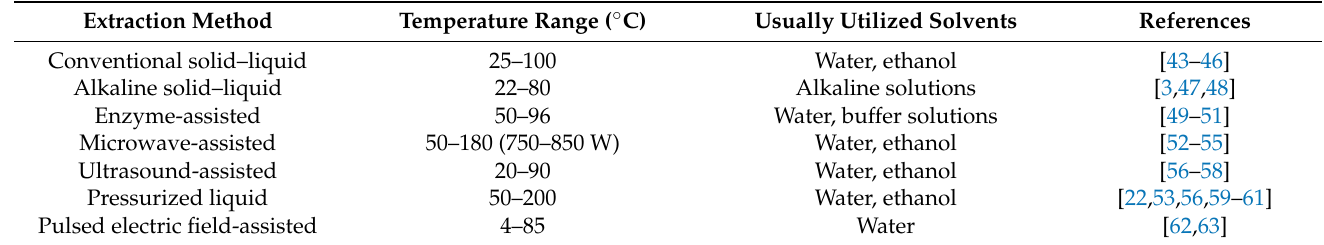
Table 2. Extraction methods to obtain β -glucans from food/natural